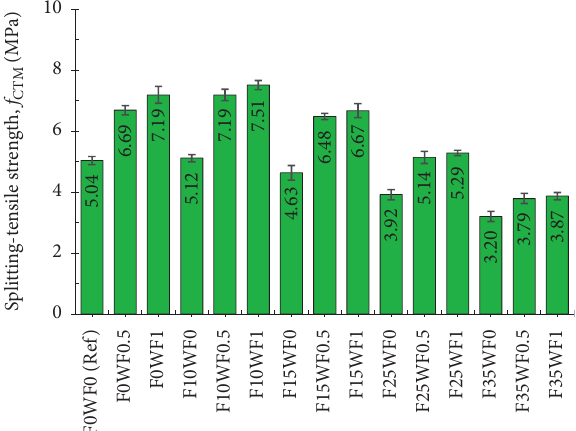
CM values of HSC: (a) 28 days and (b) 120 days.